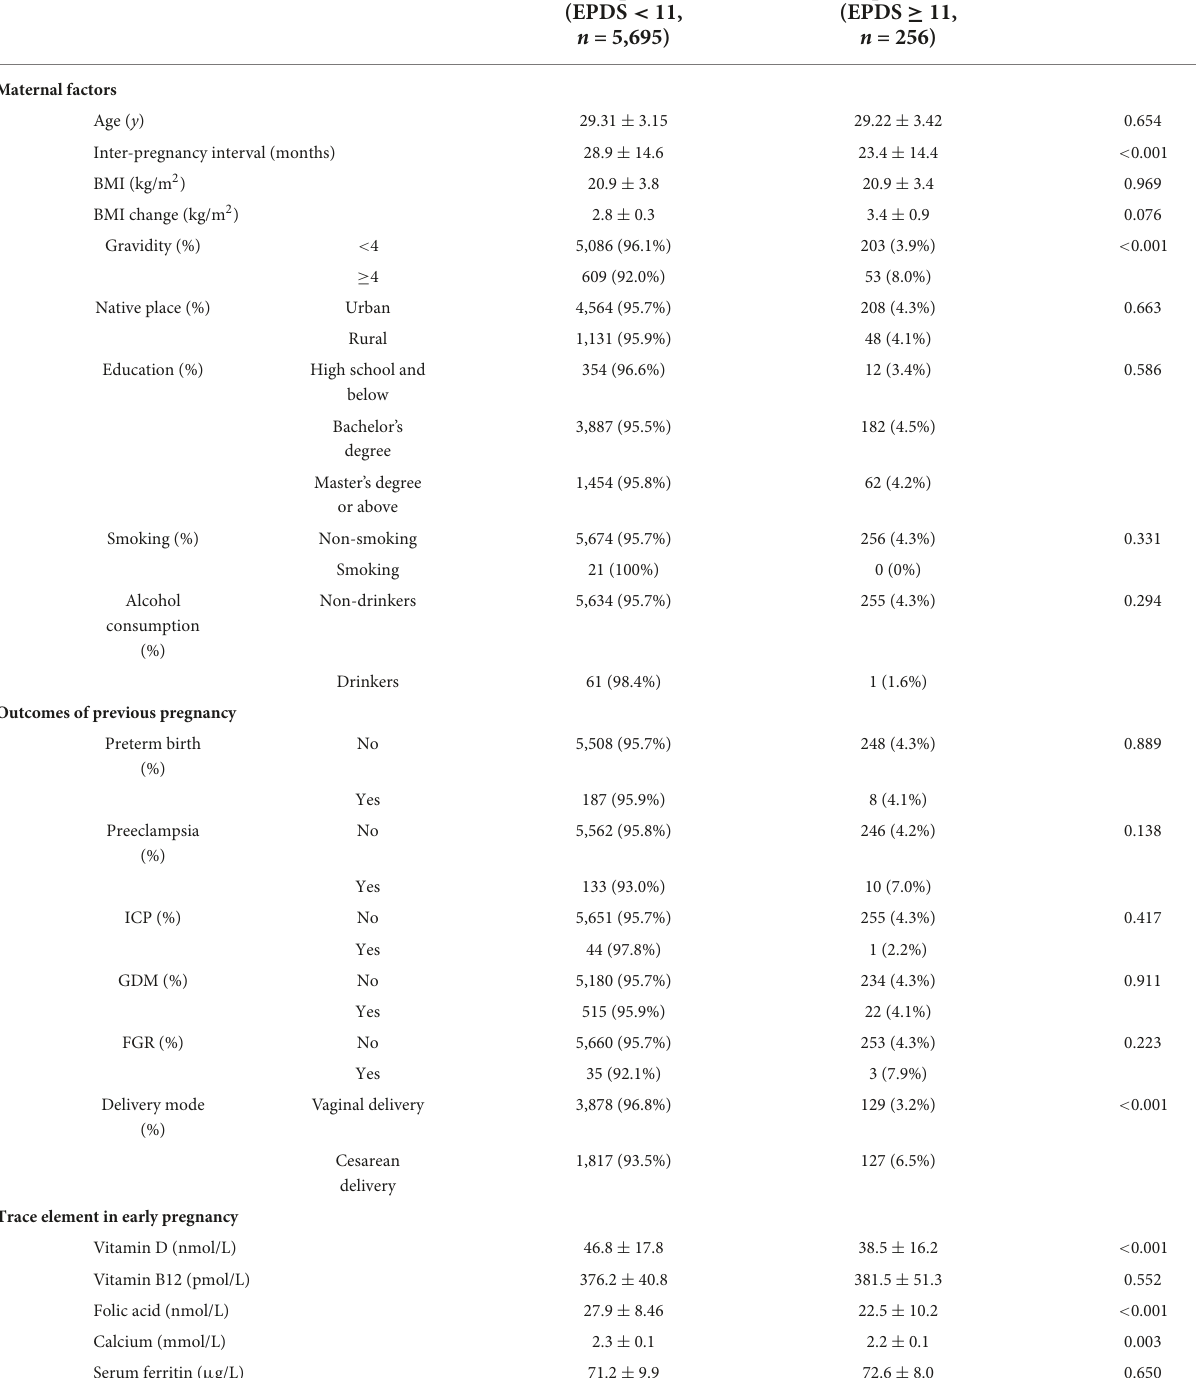
TABLE 1 Baseline characteristics of patients in the